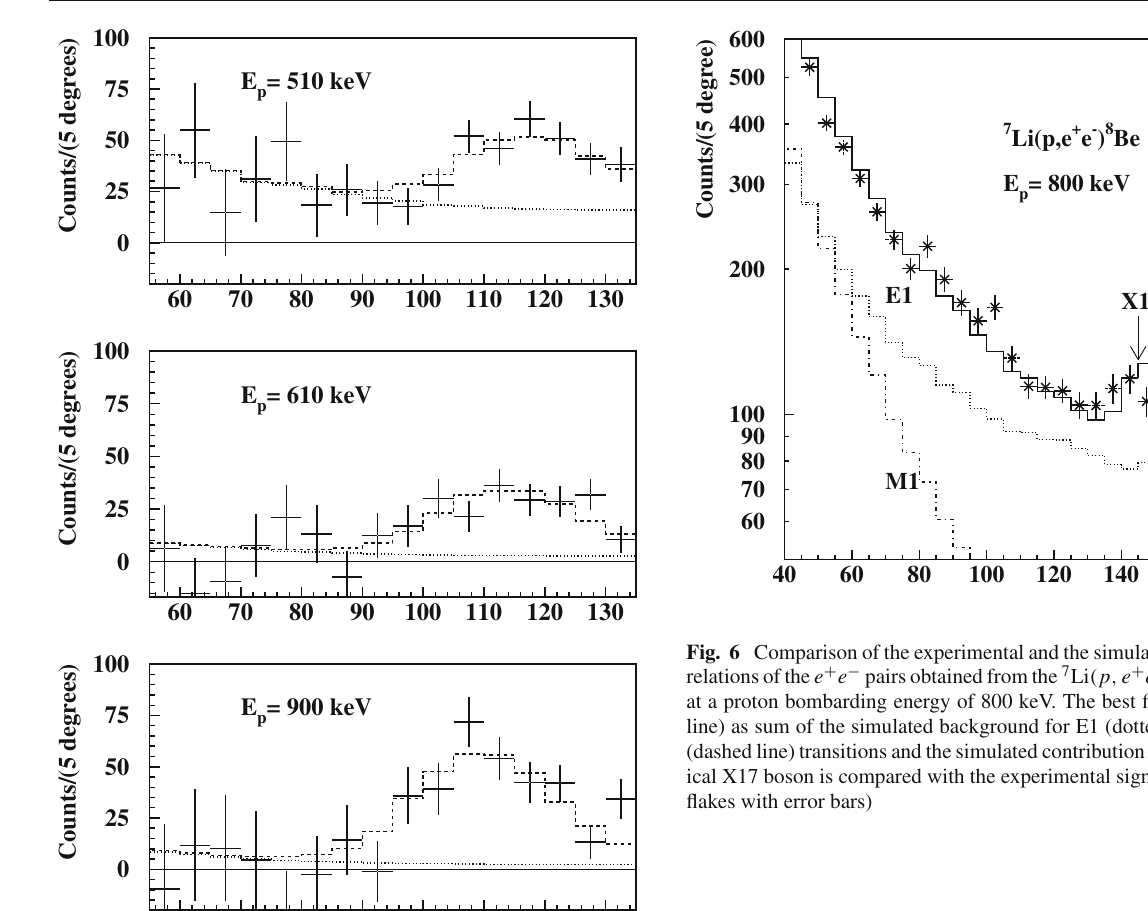
E p = 450 keV, 650 keV, 800 keV and 1100 keV. As a typical